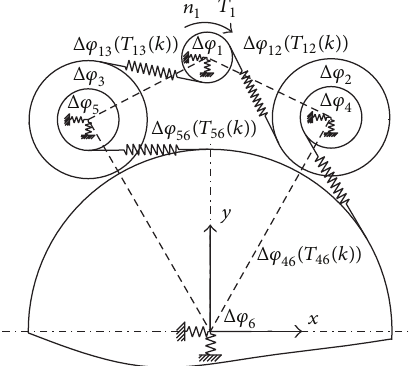
Here, 𝑇 1 is input torque; 𝑛 1 is input speed; 𝐾 𝑖𝑗 (𝑖 = 1, 𝑗 = 2, 3; 𝑖 = 4, 5, 𝑗 = 6) is time-varying mesh stiffness; and transmitting torque of each gear pair is expressed as 𝑇 𝑖𝑗 = 𝑇 𝐼 −𝐼 𝑖𝑗 𝑗𝑖 ( 𝑖𝑗 is the transmission ratio; 𝑟 𝑟 𝑏𝑖 and 𝑏𝑗 stand for the basic radius, and the teeth number, respectively, for the gear 𝑗 and pinion 𝑖 ; 𝑝 𝑢 and 𝑔 V ( 𝑢 = 1, 𝑗 = 2, 3; V = 4, 5, 𝑗 = 6 ) are the symbol of